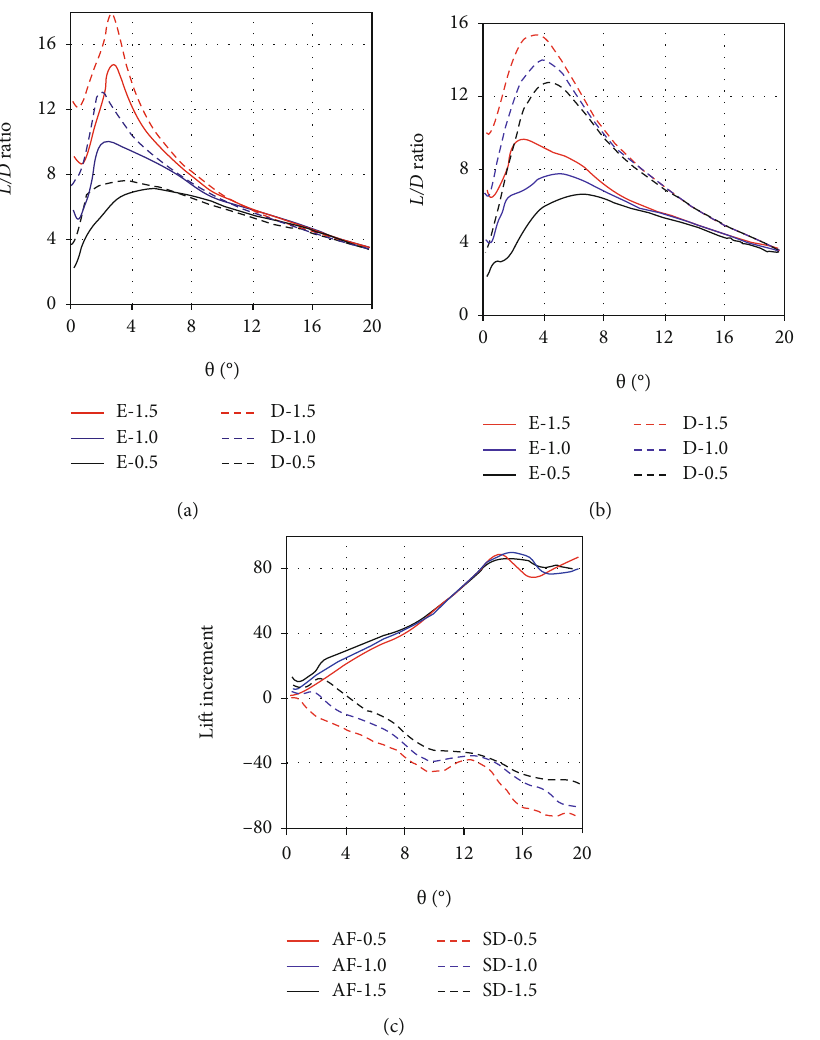
Figure 12: The L / D ratios and lift increment of the anal and second dorsal fi ns in the two morphing states with the yaw angular velocity of ω = 0 : 5 rad/s, 1 rad/s, and 1.5rad/s, respectively: (a) the L / D ratio of the anal fi n; (b) the L / D ratio of the second dorsal fi n; (c) the lift increment of the anal and second dorsal fi